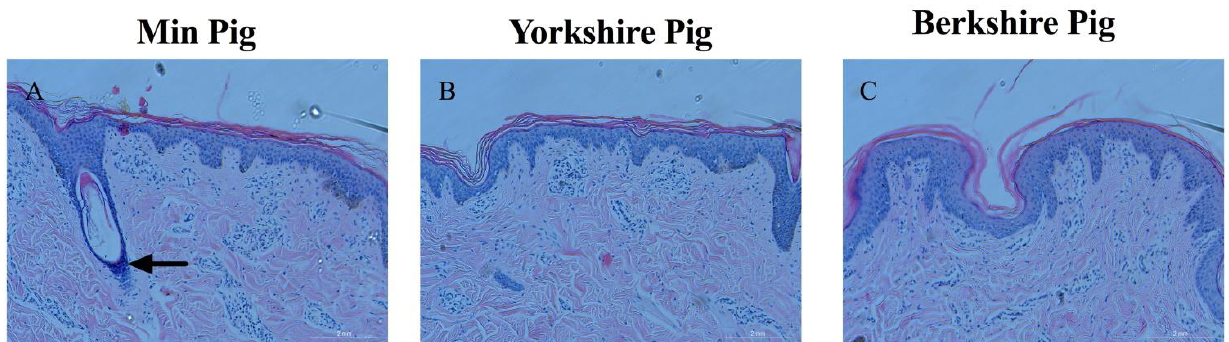
Figure 2. The hair follicle of primary hair and secondary hair samples were studied from the Min pig, Berkshire pig, and Yorkshire pig for histological analysis. Tissue sections of the hair follicles of Min pigs, Yorkshire pigs, and Berkshire pigs in ( A – C ). ( A ) The secondary hair follicles of Min pigs with the outer root sheath cells. ( B , C ) The secondary hair follicle of Yorkshire pigs and Berkshire pigs did not develop under the skin, which indicates that the hair follicle is in the telogen phase. The magnification of the microscope was 200×.